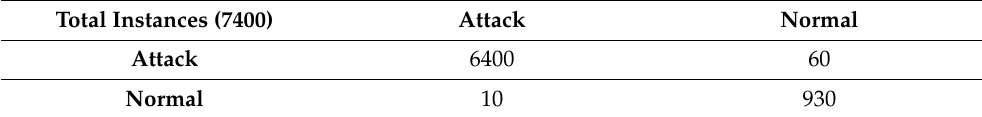
Table 7. Testing confusion matrix of the SVM.